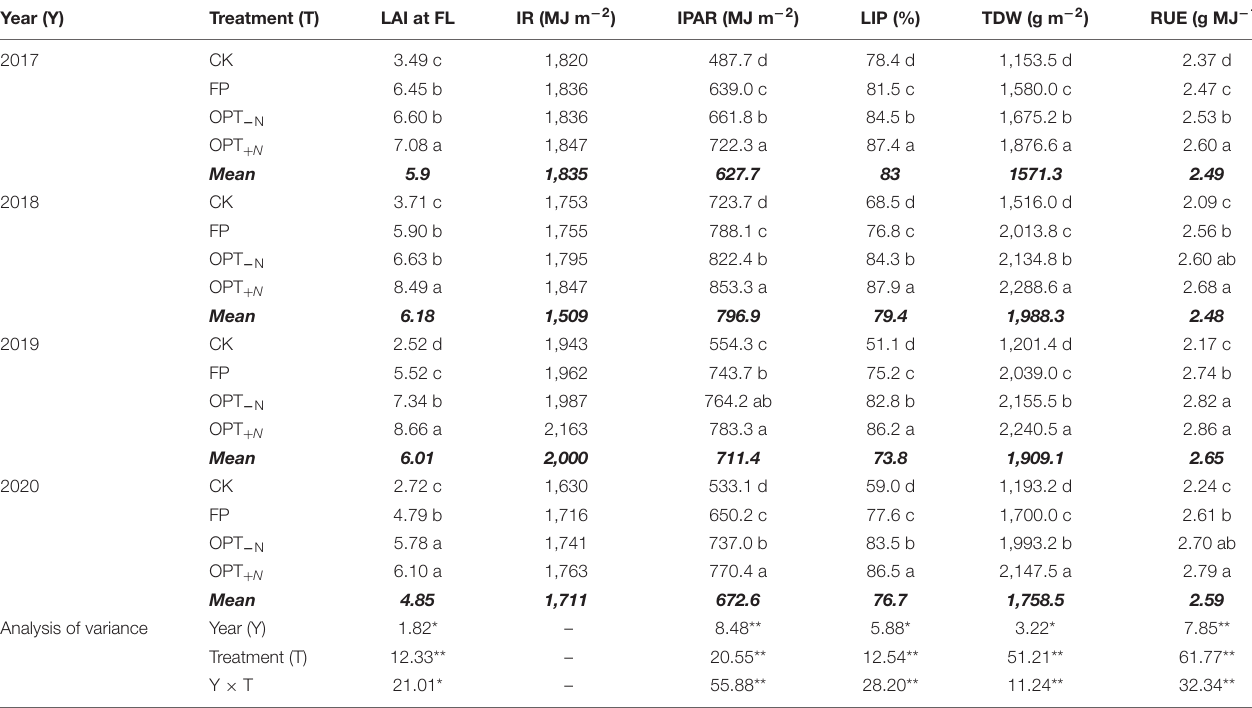
TABLE 4 | Leaf area index (LAI) at flowering (FL), aboveground total dry weight (TDW), radiation use efficiency (RUE), and related parameters at maturity for four treatments at Jingzhou. Year (Y)